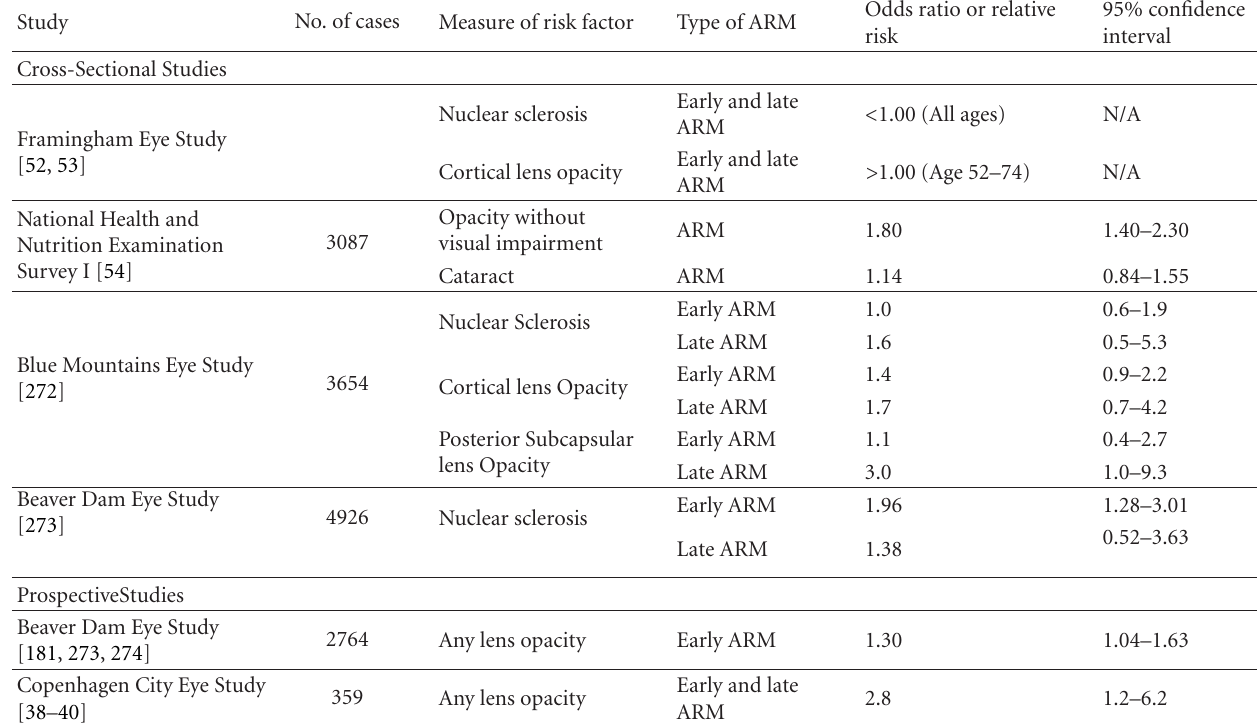
Table 18: Studies investigating the relationship between cataract and risk for ARM.